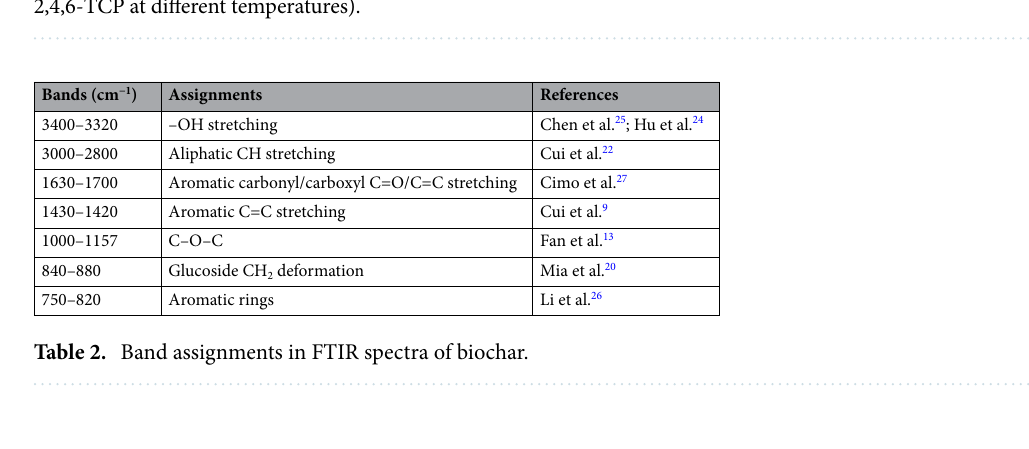
Figure 1. Infrared spectra of biochars from different process (BB, PB, ABB, APB without temperatures mean the biochars no sorbing 2,4,6-TCP; BB, PB, ABB, APB with different temperatures mean the biochars sorbing 2,4,6-TCP at different temperatures).